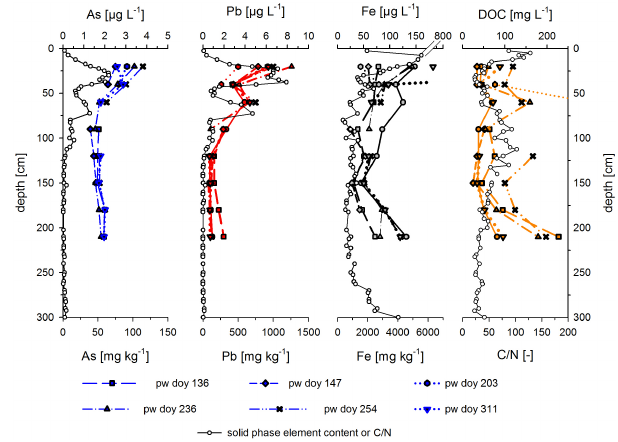
Figure 5. As and Pb contents of the long peat core taken at the Odersprung bog and carbon nitrogen ratios (C / N) as indicators of peat decomposition. Pore water concentrations of As (left, blue), Pb (center left, red), Fe (center right, black) and DOC (right, orange) along a depth profile